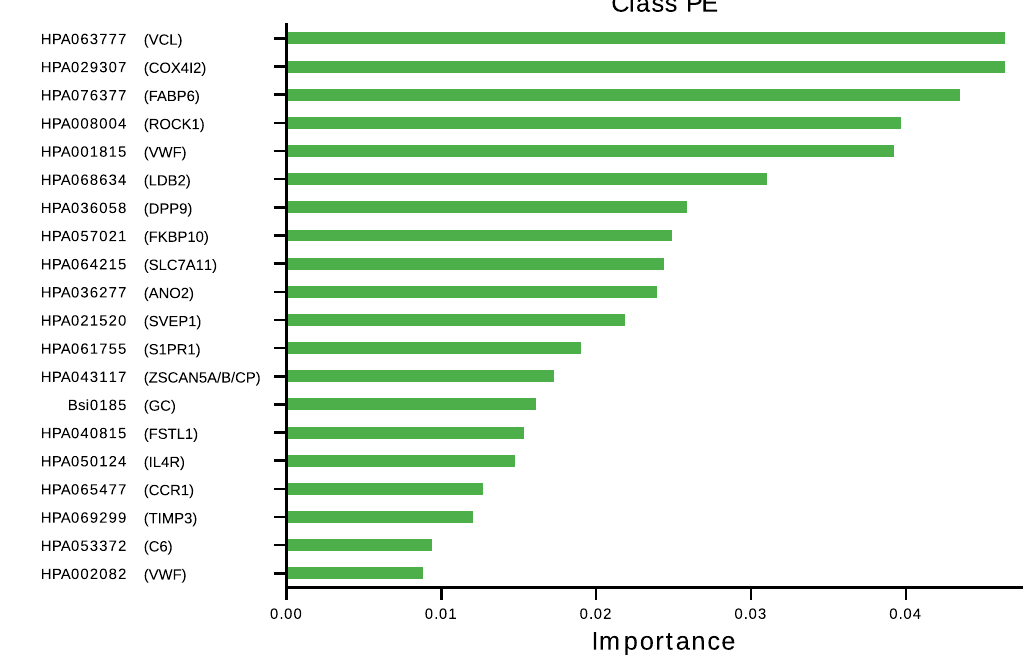
Figure 3. List of the top 20 antibodies contributing the most to the prediction model for PE.